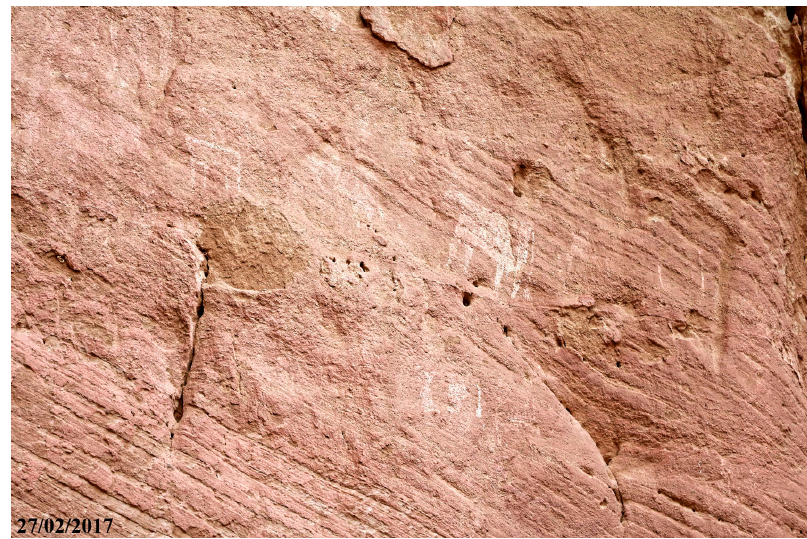
Figure 14. Remains of white cattle figures on the western shelter sidewall, 5 m above the ground (P9). Two engraved cattle figures are present. The one to the right is deeply engraved and much worn; the one to the left is lightly engraved (Photo: Mauro Colella).